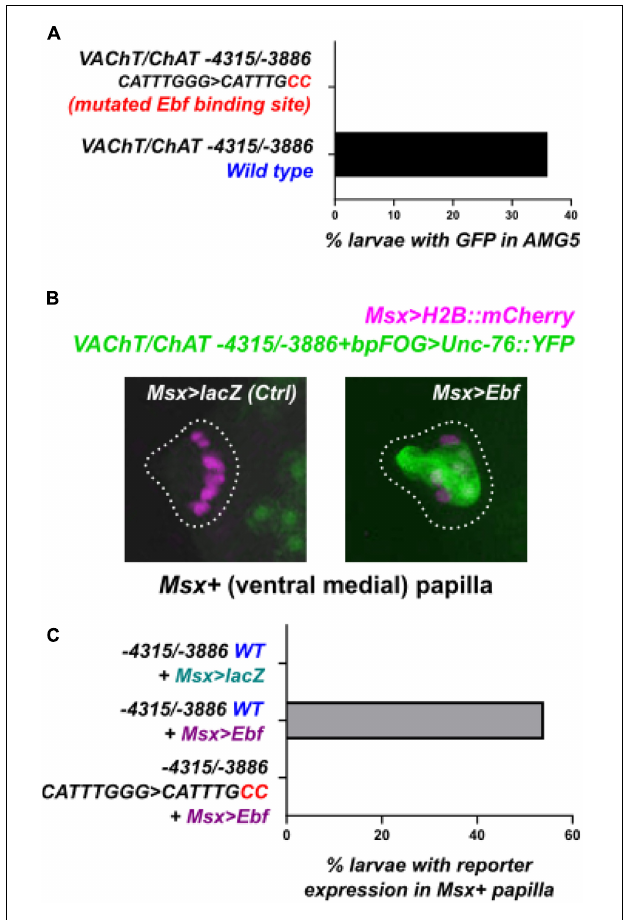
FIGURE 3 | An Ebf binding site is necessary for VAChT/ChAT reporter activity. (A) Mutating the Ebf binding site in the minimal AMG5-specific VAChT/ChAT cis -regulatory element was sufficient to abolish its activity in AMG5. Mutated reporter n = 50, wild-type reporter n = 44. (B) The AMG5-specific VAChT/ChAT reporter can be ectopically activated in ventral papilla cells at 15.5 h post-fertilization (hpf) at 20 ◦ C, by overexpressing Ebf there (using Msx > Ebf). No expression is seen in the negative control electroporated with the neutral construct Msx > lacZ instead. Images are confocal Z stack projections. (C) Yet Ebf overexpression in the ventral papilla does not cause ectopic expression of the mutated VAChT/ChAT reporter, suggesting the Ebf binding site is indispensable for Ebf-mediated activation of this element. For each of the three conditions, n =